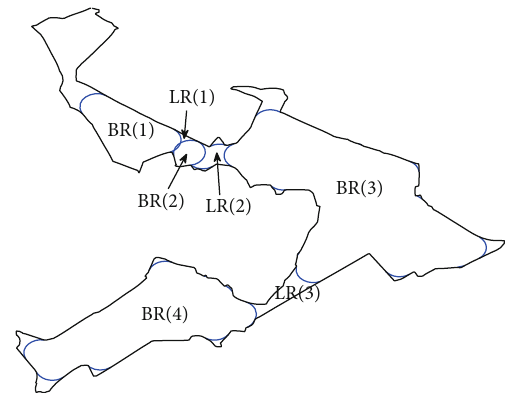
Figure 1: Geometrically allowed oil-water interfaces and determined BR and LR regions in an individual Bentheim Figure 2: Initial water-oil fl uid con fi guration before gas invasion in sandstone pore space. Black curve: pore boundary; blue curve: an individual Bentheim sandstone pore space. Red region: oil; blue oil-water interface ( r = 8 pixel lengths and θ = 0 ° ). ow ow region: water ( r = 8 pixel lengths and θ = 0 ° ). ow ow